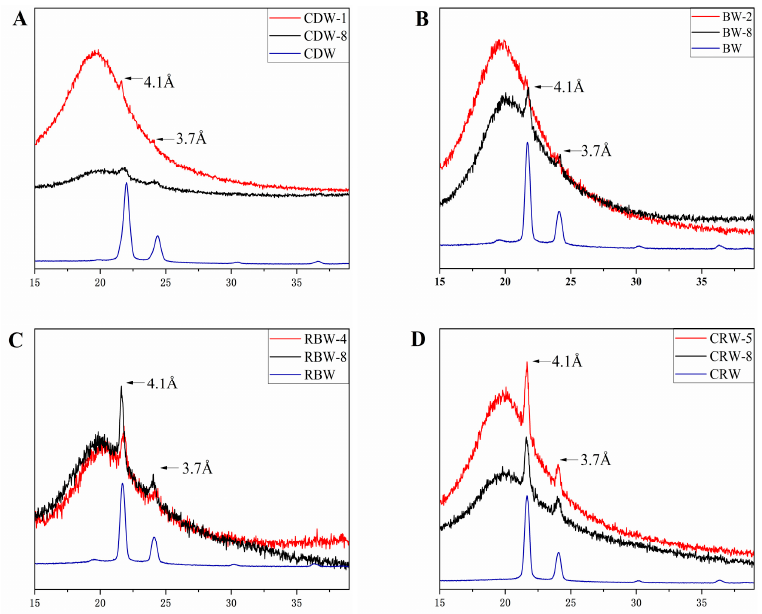
Figure 4. ( A ) X-ray diffraction spectra of CDW-1, CDW-8, and CDW; ( B ) X-ray diffraction spectra of BW-2, BW-8, and BW; ( C ) X-ray diffraction spectra of RBW-4, RBW-8, and RBW; ( D ) X-ray diffraction spectra of CRW-5, CRW-8, and CRW; the red line represents the critical concentration and the black line represents 8 wt.%, blue line represents gelling agent (25 °C).